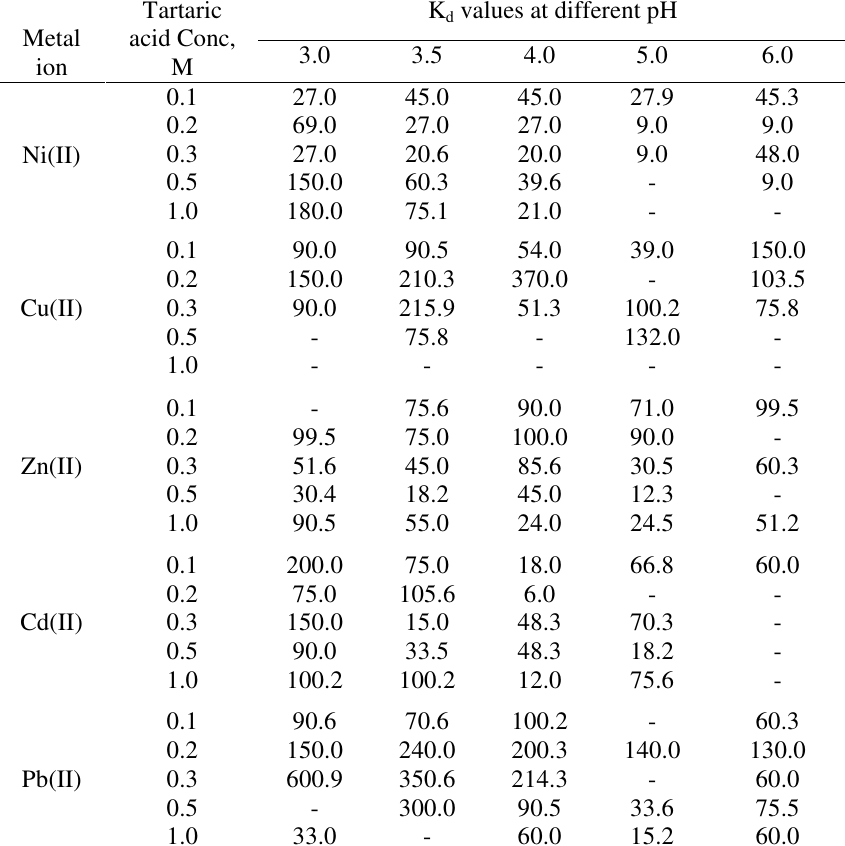
Table 3 . K values of metal ions on AFM resin in tartaric acid media at different d